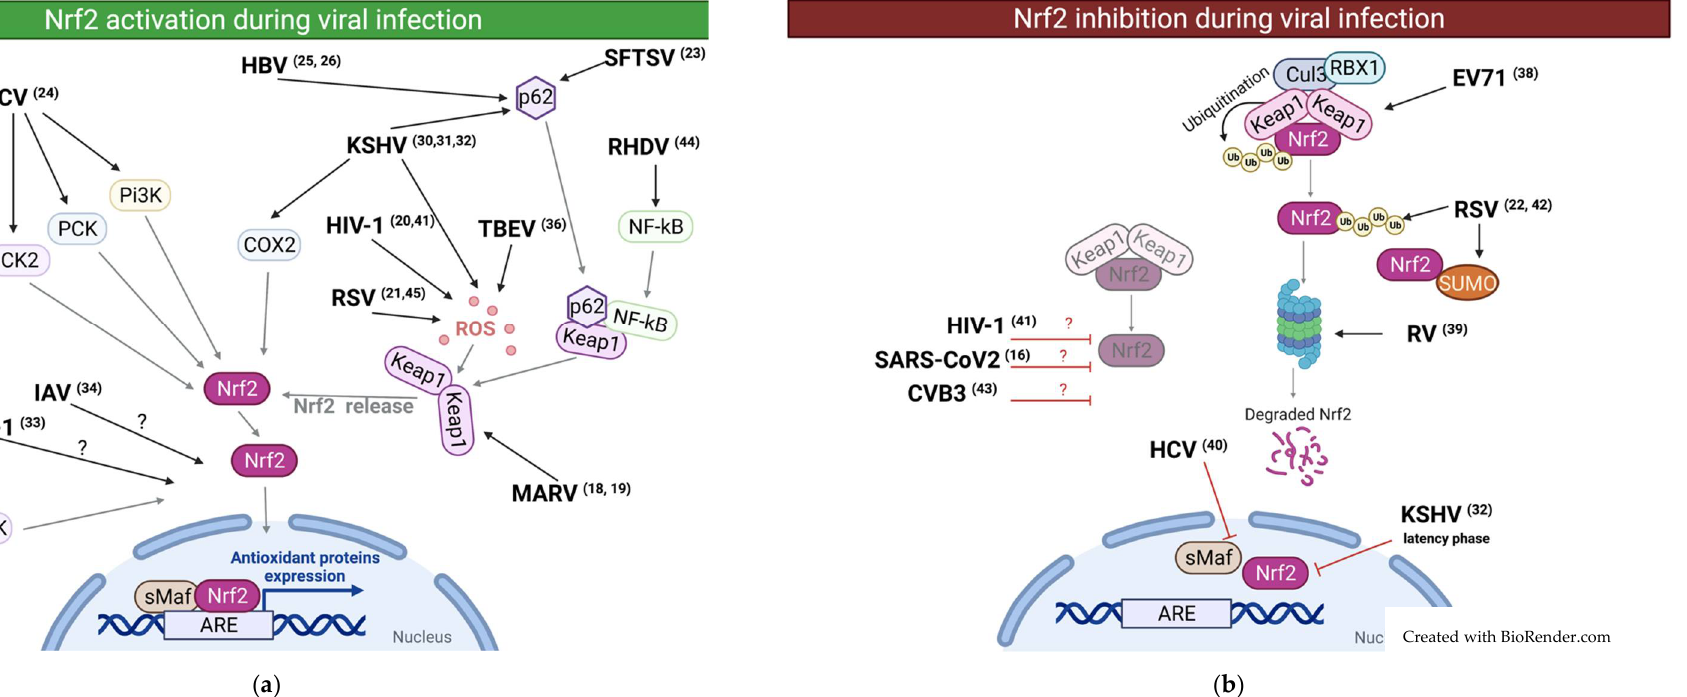
Figure 1. Graphical abstract of effect observed in the literature on NRF2 during viral infections. ( a ) Graphical overview of the activation of NRF2 during viral infection. ( b ) Graphical overview of the inhibition of NRF2 during viral infection.